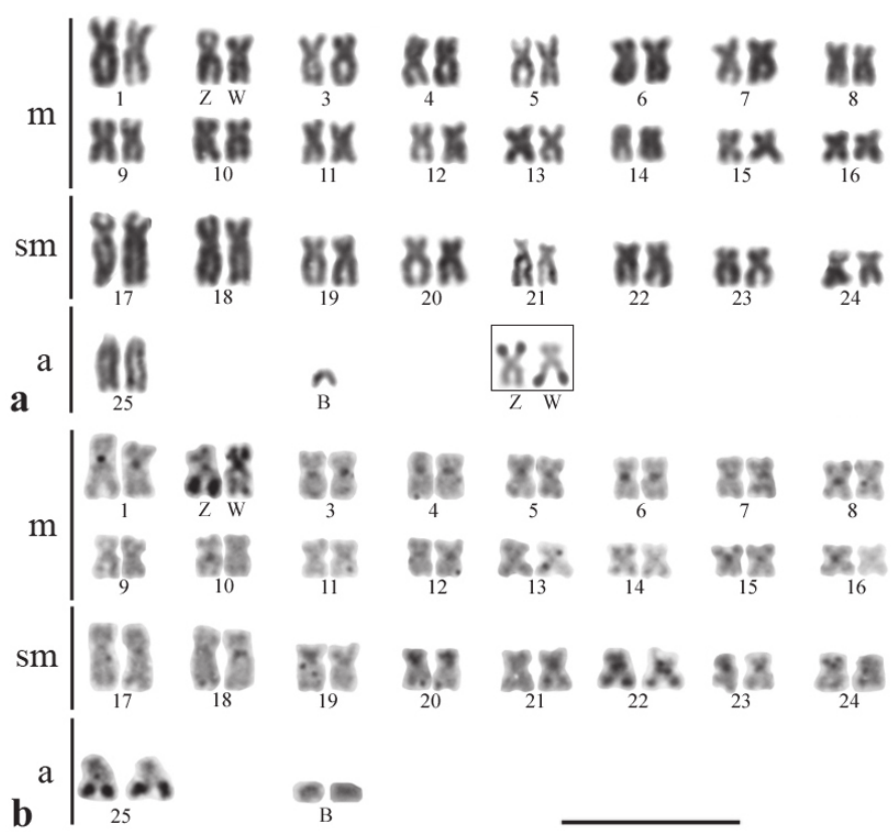
Fig. 3. Karyotypes of female specimens of Characidium pterostictum from Apiaí, SP, after conventional Giemsa staining (a) and C-banding (b). Note the differential patterns of heterochromatic blocks on the Z and W chromosomes and the heterochromatic B-chromosomes In the box, the Z and W chromosomes carrying the NORs in an inverted position. Scale bar = 10